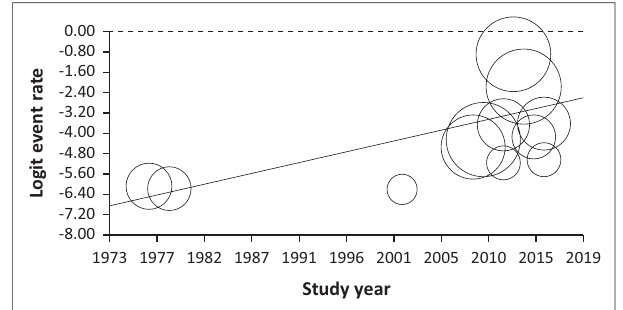
FIGURE 3: Prevalence regression by years of different studies.